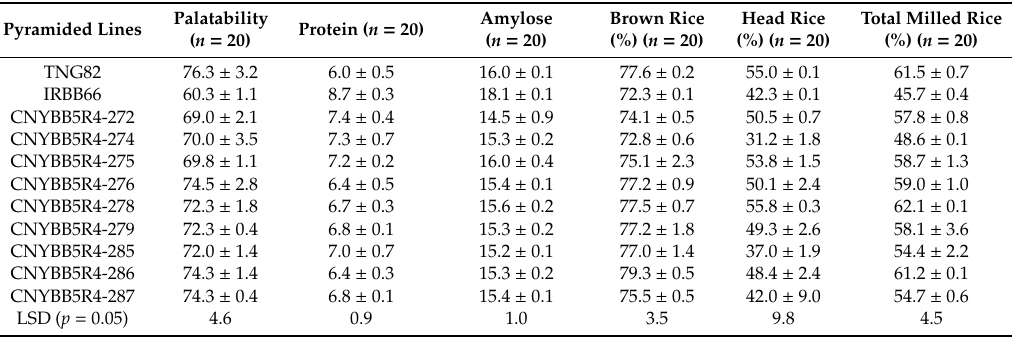
Table 3. Grain quality of parental and five-gene-pyramided BC 3 F 4